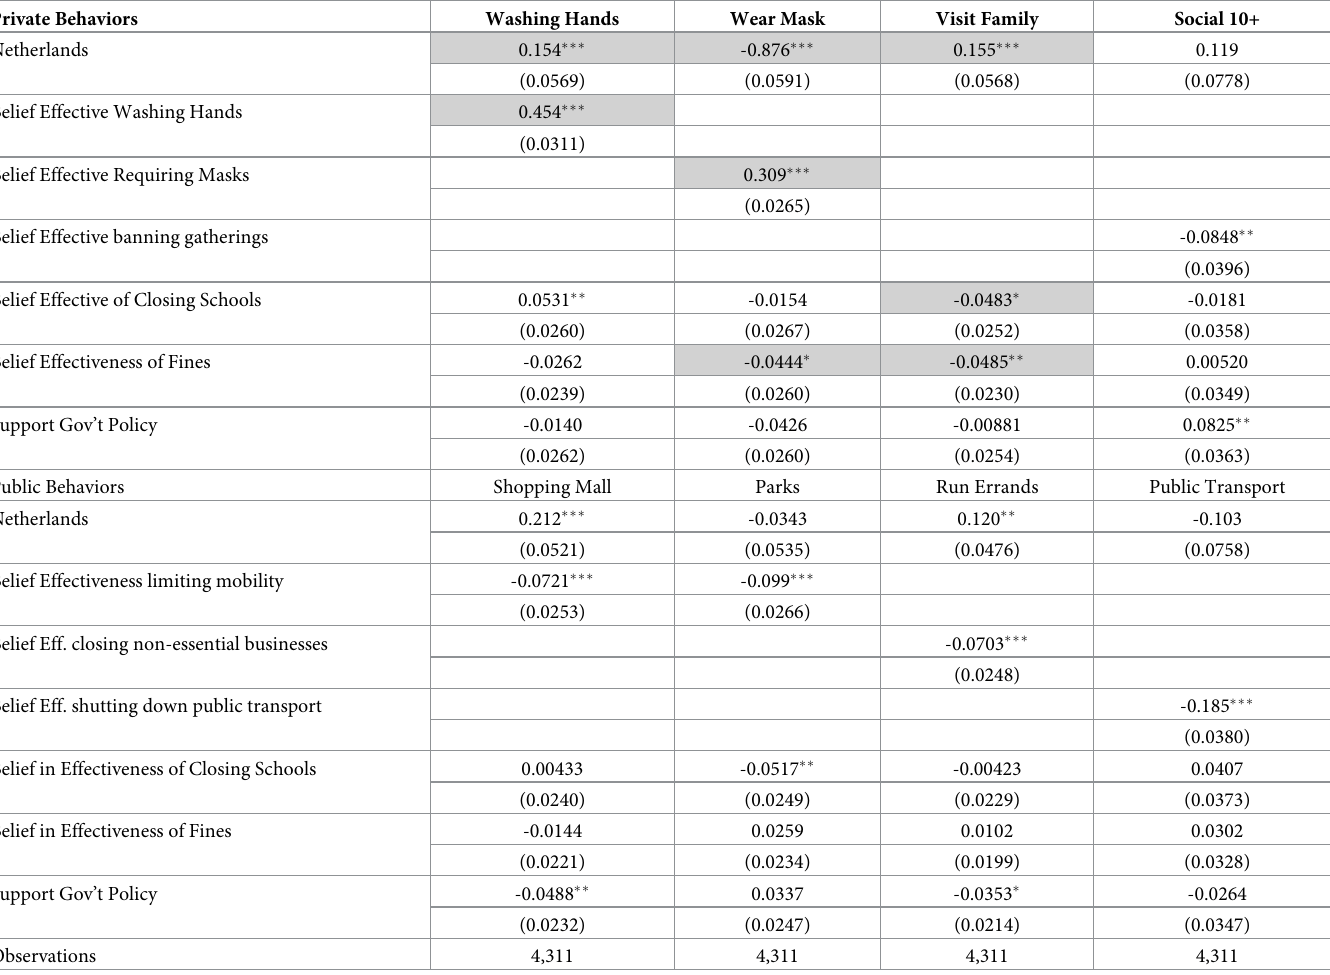
Table 2. The effect of beliefs on private and public